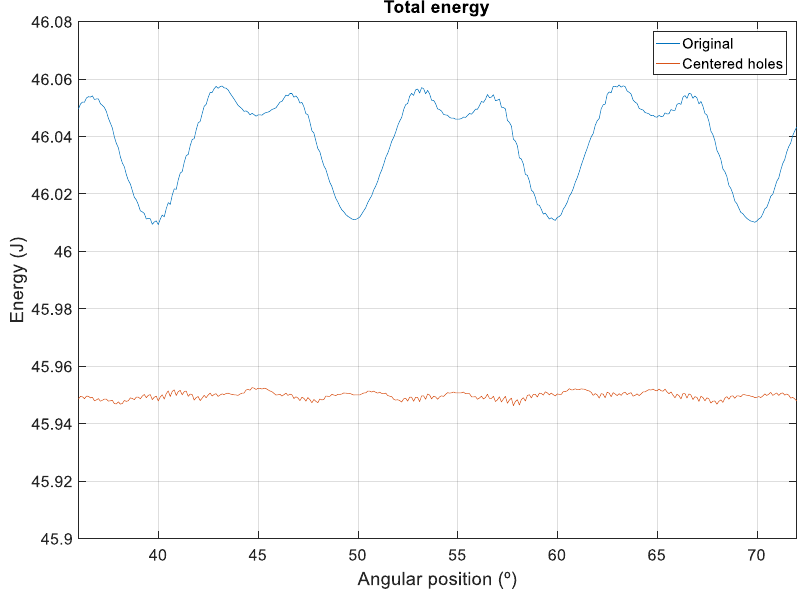
Figure 12. Total magnetic energy.